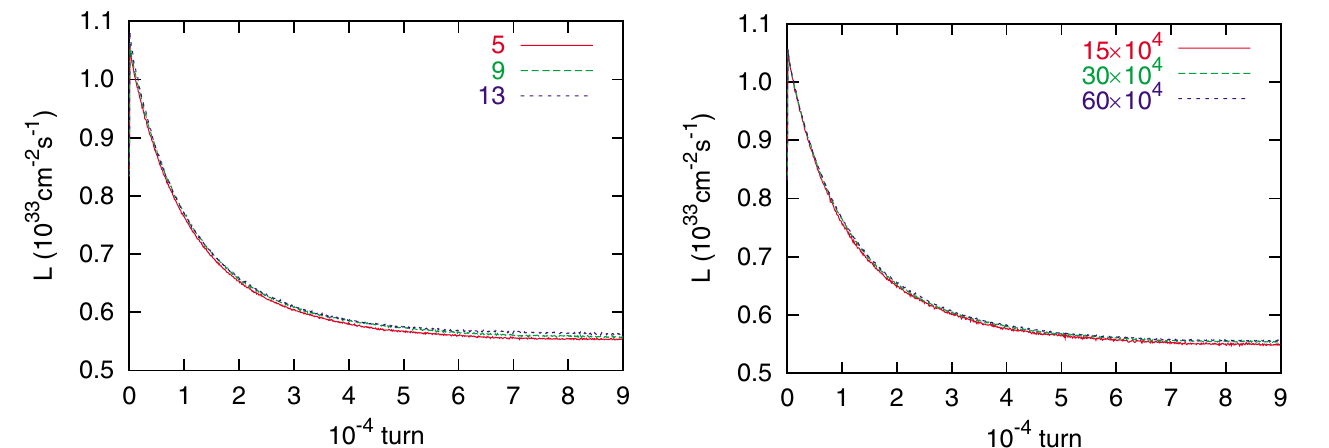
FIG. 4. (Color) Evolution of luminosity for various slice numbers.